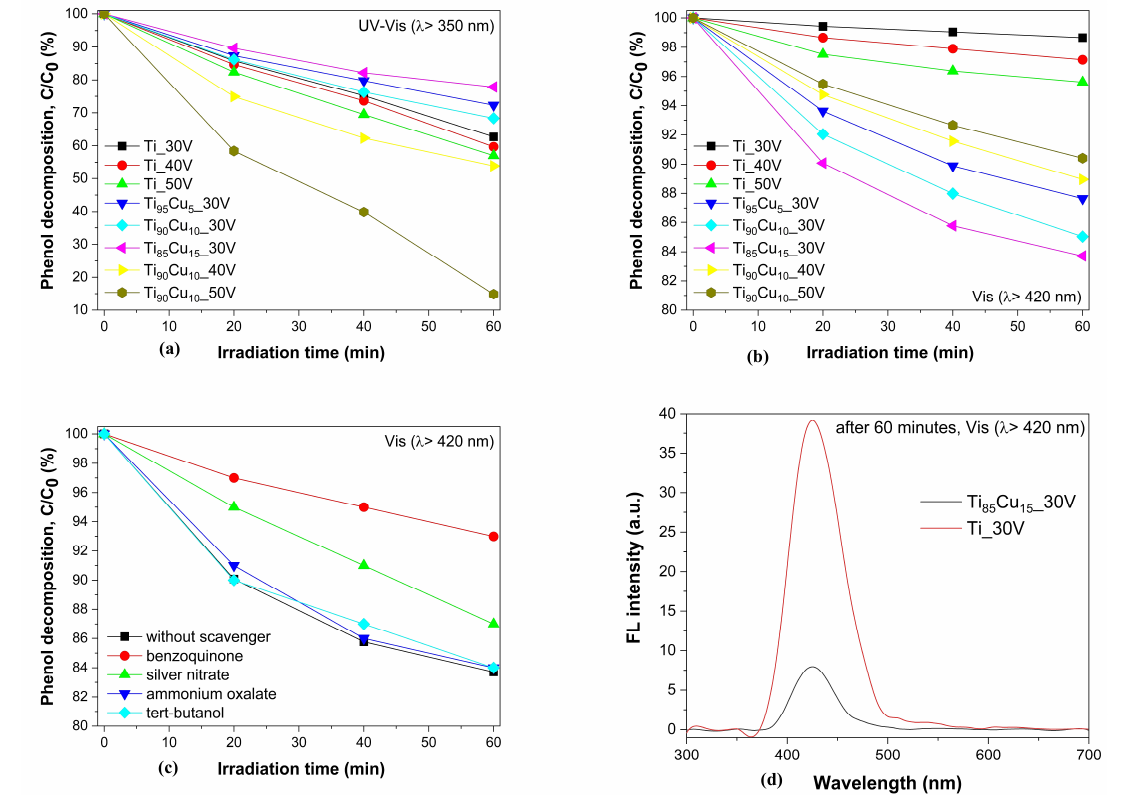
Figure 5. Kinetics of photocatalytic degradation of phenol under UV-Vis ( a ) and Vis ( b ) irradiation, photocatalytic decomposition of phenol under visible light irradiation in the presence of scavengers, and Ti 95 Cu 15 _30V sample ( c ) and • OH radical generation efficiency under Vis irradiation ( d ) in the presence of selected